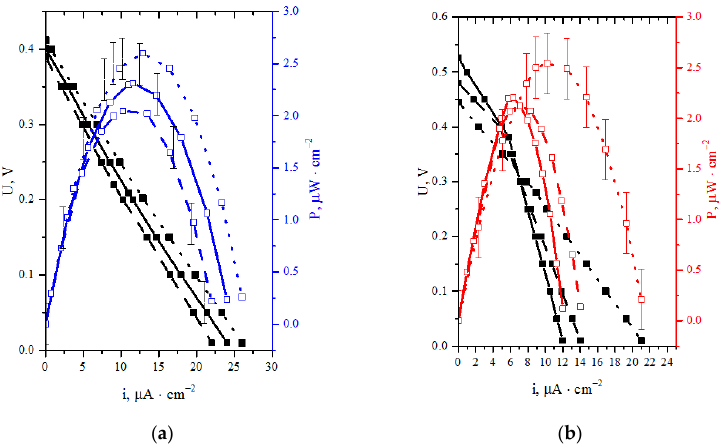
Figure 6. Discharge and specific power characteristics for two systems: ( a ) laccase (cathode) — Au/CNT (anode) BFC; ( b ) laccase (cathode) —BM + TEG (anode) BFC.